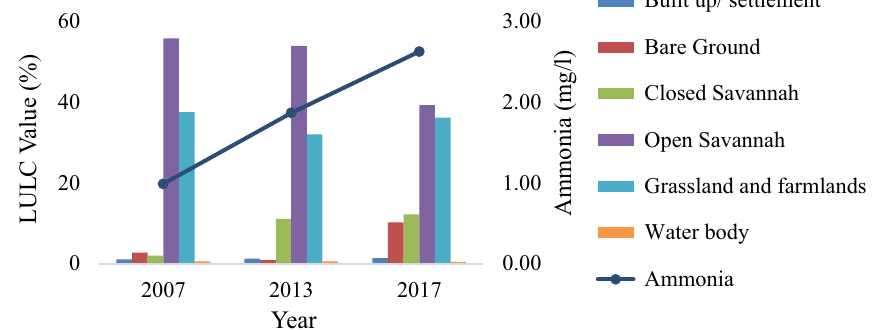
Fig. 9 Ammonia variation and land use and land cover